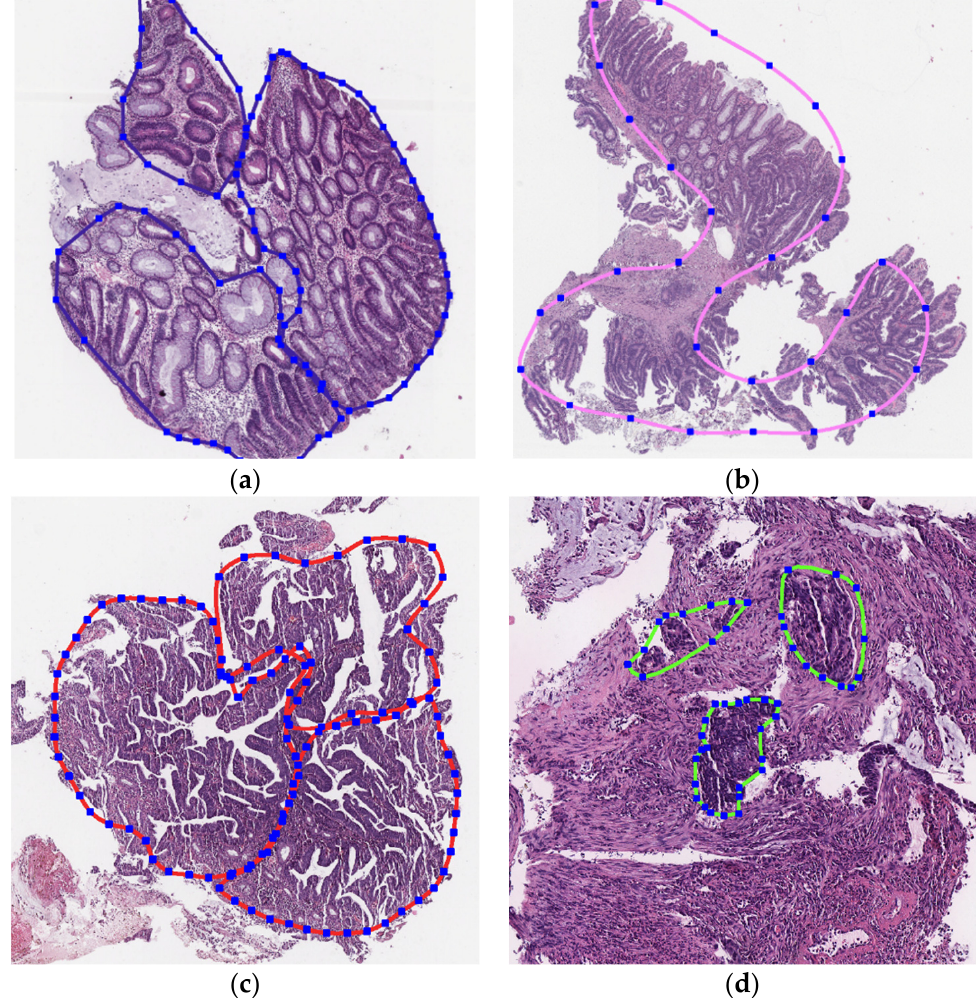
Figure 1. Examples of labelled hematoxylin- and eosin (H and E)-stained colorectal tissue slides stained with the labelled hematoxylin and eosin (H and E) of different classes: ( a ) tubular adenoma (TA); ( b ) villous adenoma (VA); ( c ) well-differentiated adenocarcinoma (AKG1); ( d ) poorly differentiated adenocarcinoma